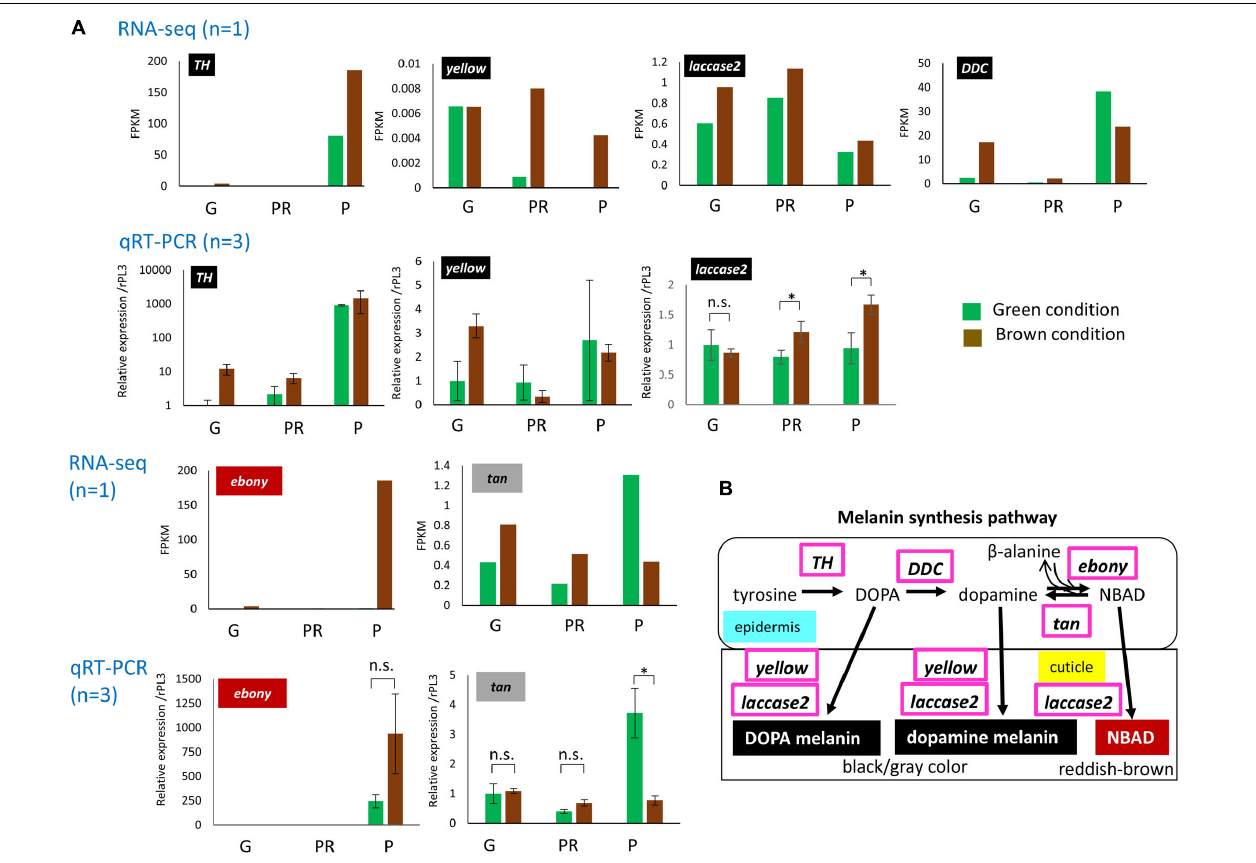
FIGURE 3 | Relative expression profiles of melanin synthesis-related genes during pre-pupal stage and at pupation under green (GC) and brown conditions (BC). (A) RNA-seq data (Upper) and qRT-PCR data (Lower) for TH , yellow , laccase 2 , ebony , and tan are shown. For DDC , only RNA-seq data are shown. G, girdling (sampling at 6–7 h after gut purge); PR, proleg release (sampling at 8–10 h); P, pupation (sampling at 24–30 h). Respective RNA-seq data ( n = 1) obtained upon candidate gene screening are shown as FPKM. We estimated the expression level of qRT-PCR data using RpL3 as an internal control. Error bars in qRT-PCR data indicate SD ( n = 3). ∗ p < 0.05 for Student’s t -test. (B) Biosynthetic pathway underlying the formation of